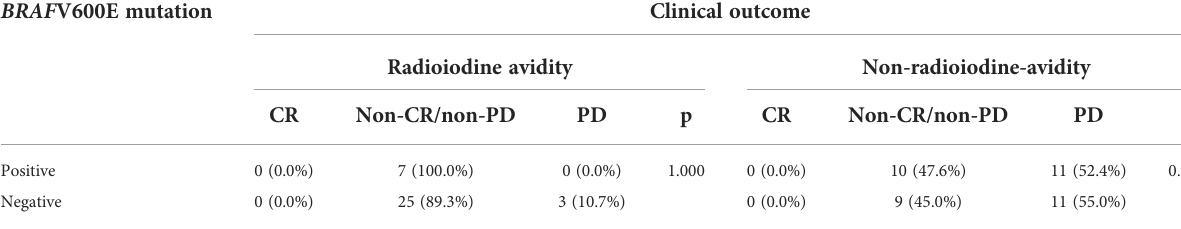
CR, complete response; PD, progressive